Question: What style of plot is this figure drawn as?
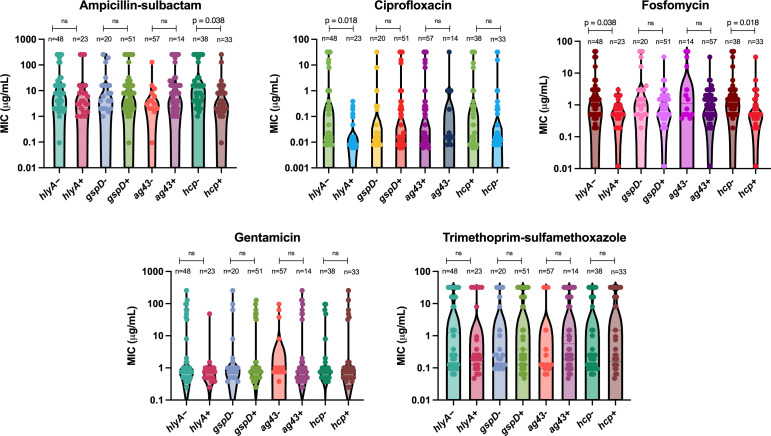
Answer: box